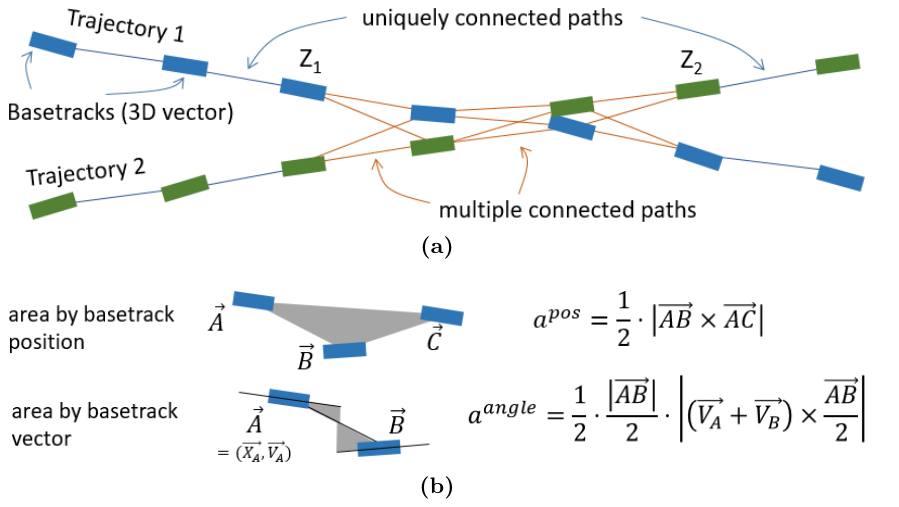
Figure 21 . (a) Two tracks come closer and there are multiple possibilities in (cid:12)nding paths. (b) Areas made by basetracks, that are used to select the best possible